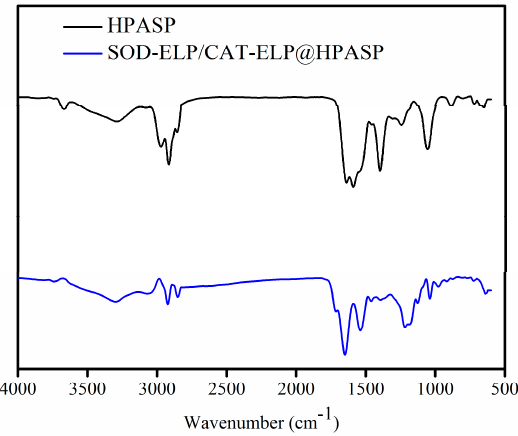
Figure 3. Confocal images. ( a ) SOD ‐ ELP immobilized on HPASP (SOD ‐ ELP@HPASP); ( b ) CAT ‐ ELP immobilized on HPASP (CAT ‐ ELP@HPASP); ( c ) SOD ‐ ELP and CAT ‐ ELP co ‐ immobilized on HPASP (SOD ‐ ELP/CAT ‐ ELP@HPASP).